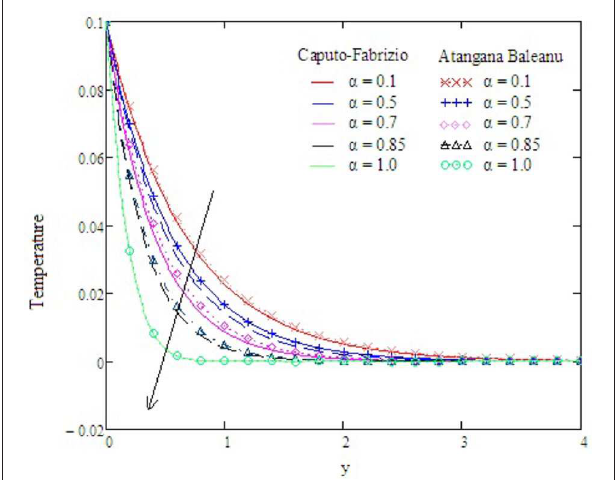
1.5, G r 2, P reff 0.1, G m 0.75, M 0.9, and = = = = =